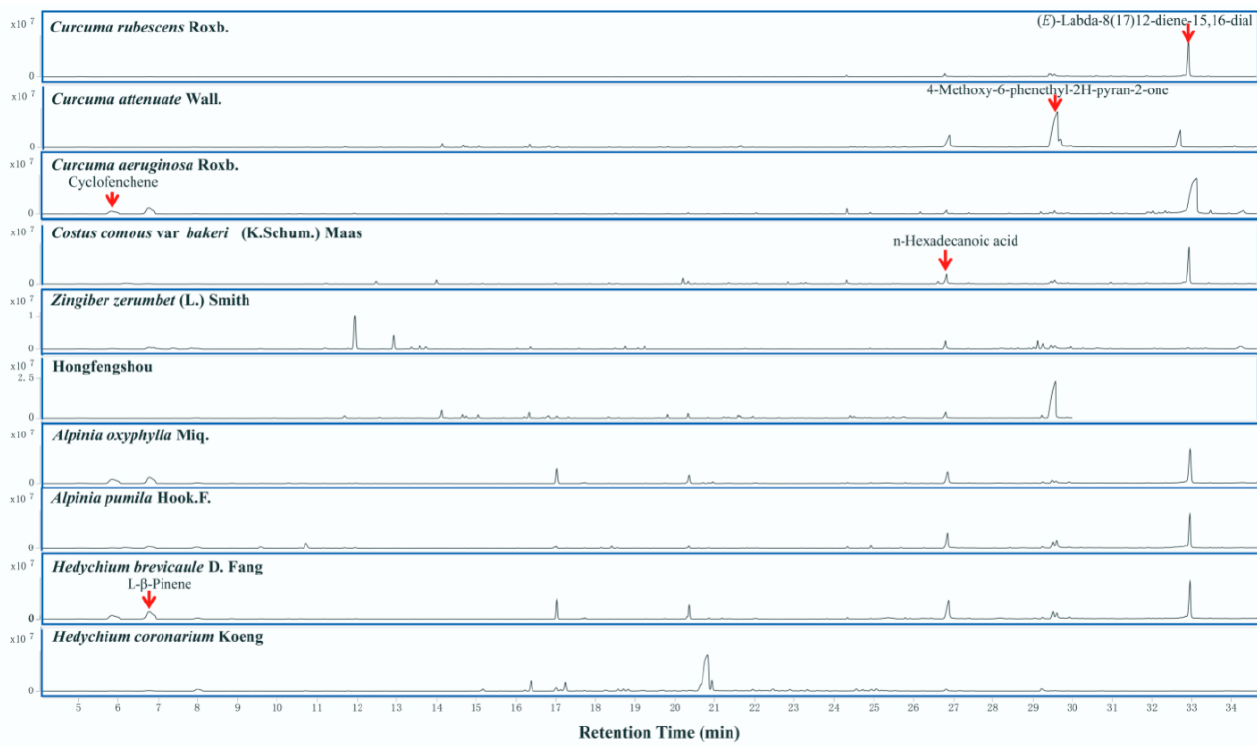
Figure 2. GC–MS TIC of different Zingiberaceae plants. The peaks indicated by the red arrows represent volatiles labeled in the figure. Peaks at the same time indicate the same substance.